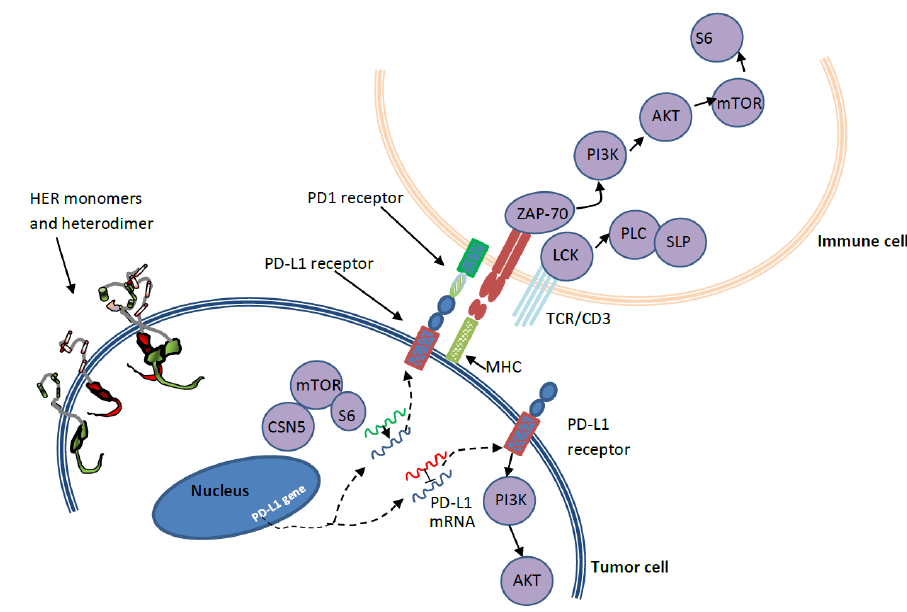
Figure 4. Upregulation of programmed death ligand-1 (PD-L1) and immune evasion by a HER + tumor cell [45,95]. MHC: major histocompatibility complex, ZAP-70: zeta-chain-associated protein kinase-